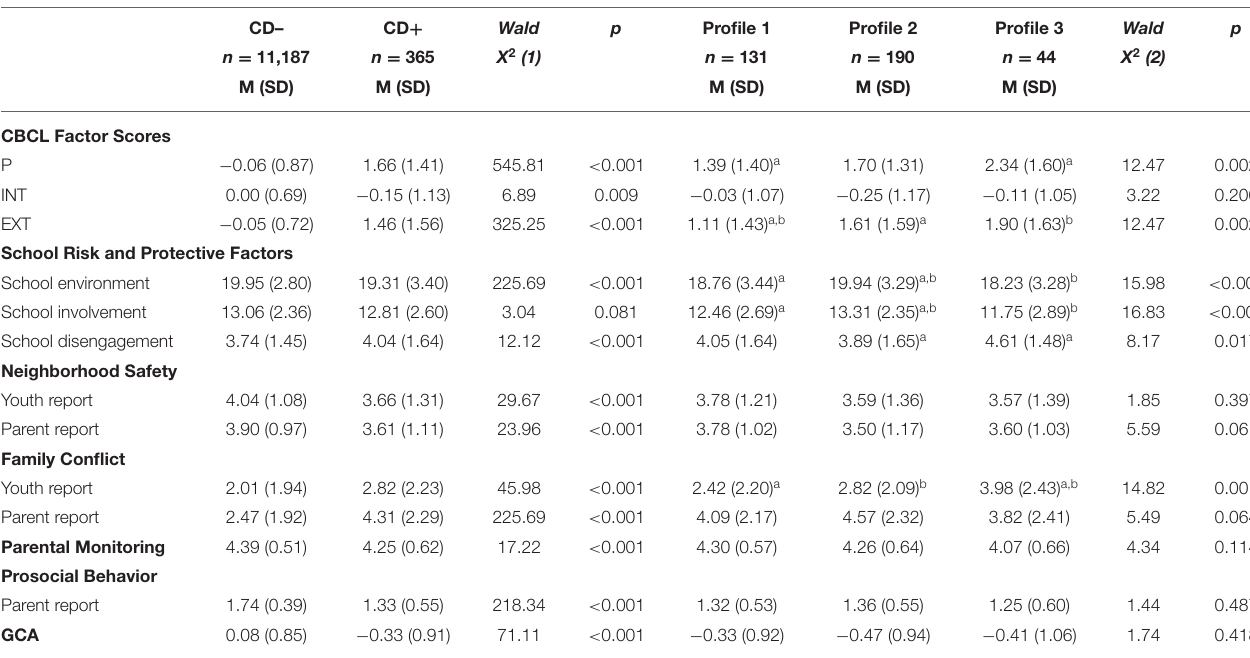
TABLE 3 | Psychopathology, social functioning, and